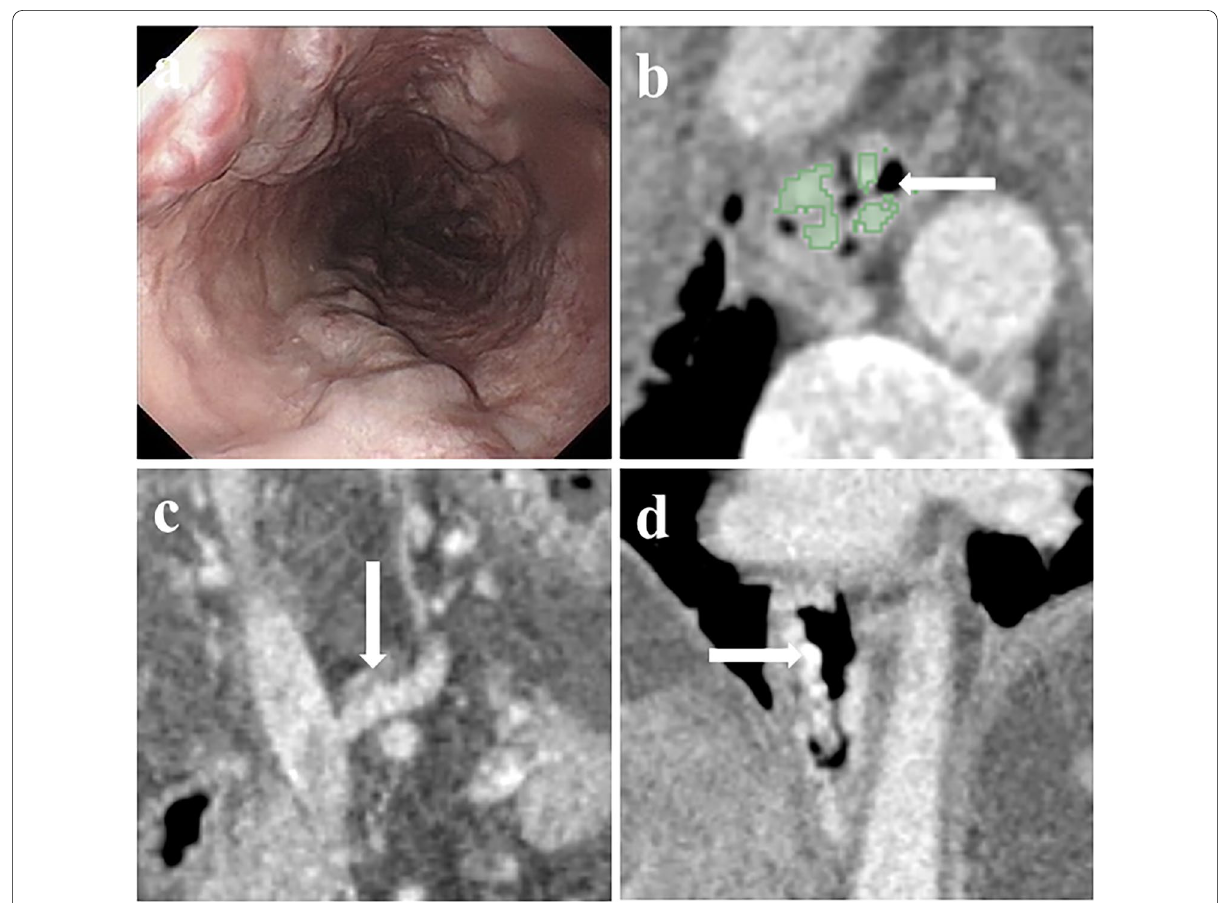
Fig. 3 Severe EV according to endoscopy in a 68-year-old man with liver cirrhosis (severe of endoscopy, maximum minor axis 6.28 mm). a The endoscopic image shows severe nodular varices; b the cross-sectional surface area (CSA) of EV (dyeing area) in the transverse section is depicted in 3D slicer; c the axial CT image shows the left gastric vein (LGV) originating from the portal vein (arrow); d 3D reconstruction has a satisfactory performance in visualizing severe EV of the lower esophagus (arrow). EV, esophageal